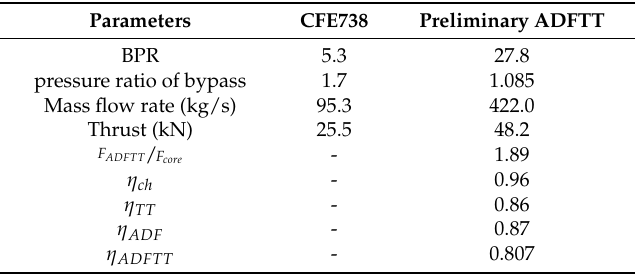
Table 1. Parameters of the prototype turbofan and